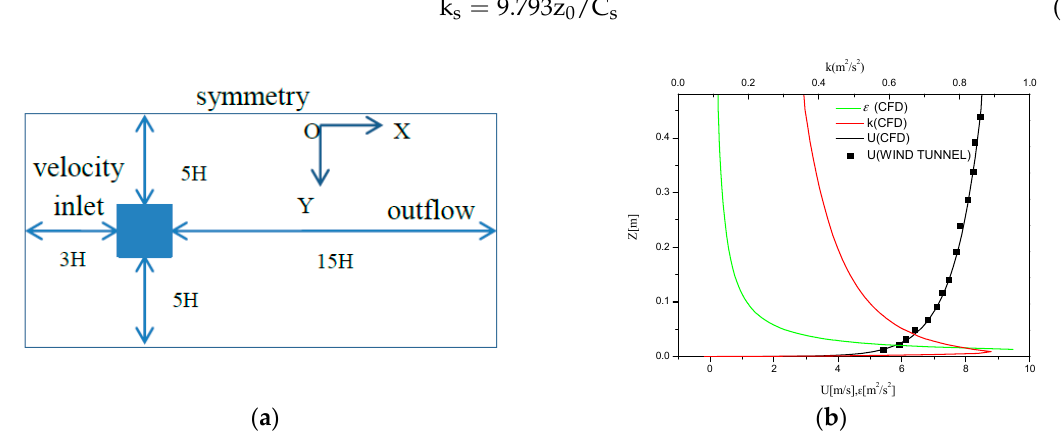
Figure 2. ( a ) Computational domain (top view); ( b ) Boundary conditions used in CFD simulations and wind tunnel experiments.